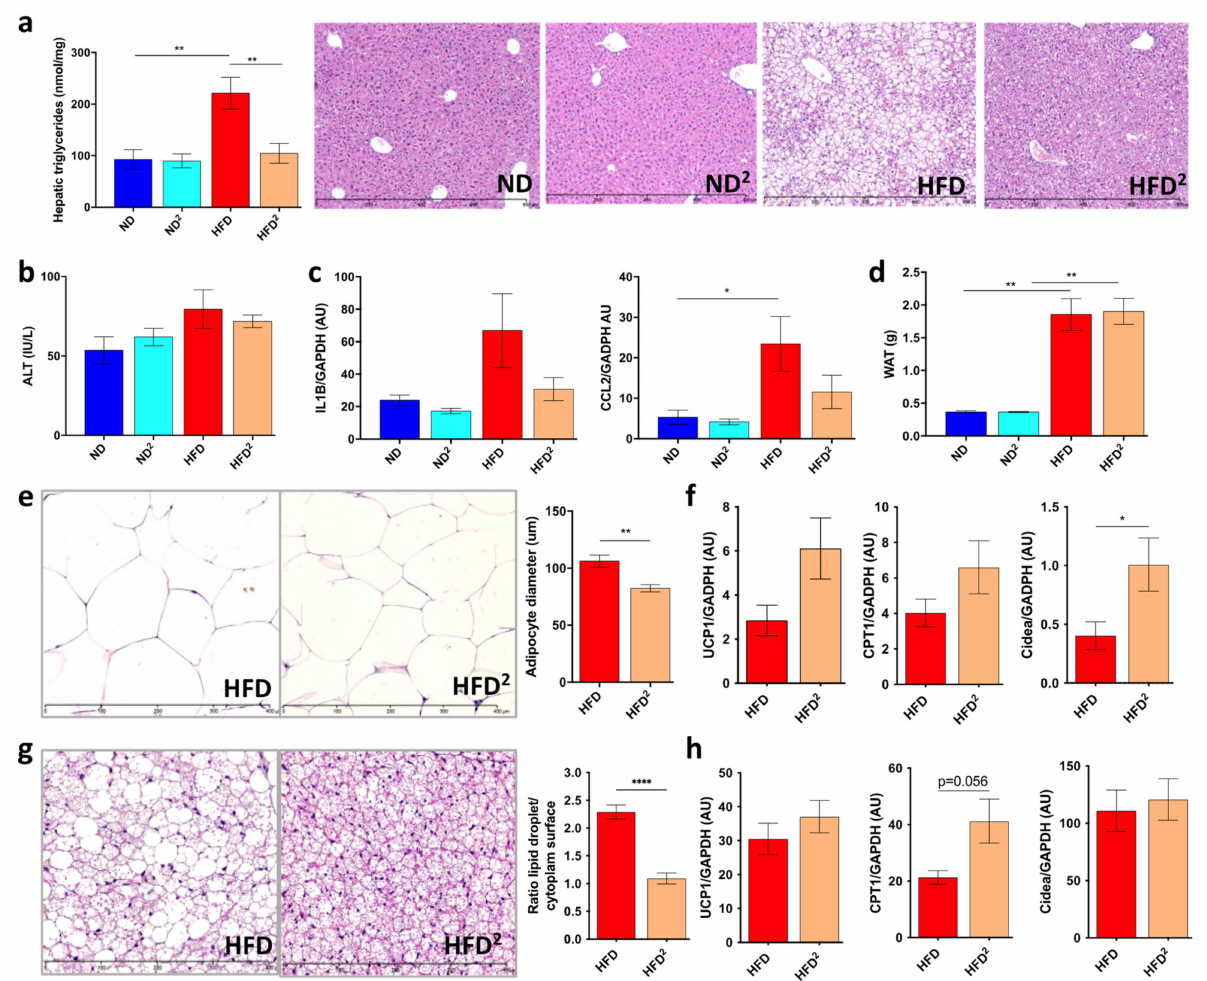
Figure 1. Pectin improves liver steatosis in mice fed a high-fat diet. Mice were fed a normal diet (ND), an ND with 2% pectin (ND 2 ), a high-fat diet (HFD), or an HFD with 2% pectin (HFD 2 ) for 16 weeks: ( a ) hepatic triglyceride con- tent and histological examination of liver tissue sections stained with hematoxylin-eosin (scale 800 µ m). ( b ) Plasma ALT. ( c ) Quantification of CCL2 and IL1 β mRNA in the liver by RT-qPCR. ( d ) Weight of epididymal white adipose tissue (WAT). ( e ) WAT section stained with hematoxylin-eosin (scale 400 µ m) and histomorphometric analysis of adipocyte diameter ( µ m). ( f ) Quantification of UCP1, CPT1, and Cidea mRNA in WAT by RT-qPCR. ( g ) Brown adipose tissue (BAT) section stained with hematoxylin-eosin (scale 400 µ m) and ratio of lipid droplets surface and cytoplasm surface. ( h ) Quantification of UCP, CPT1, and Cidea mRNA by RT-qPCR in BAT. Data represent the mean ± SEM of eight mice. * p < 0.05, ** p < 0.01, **** p <